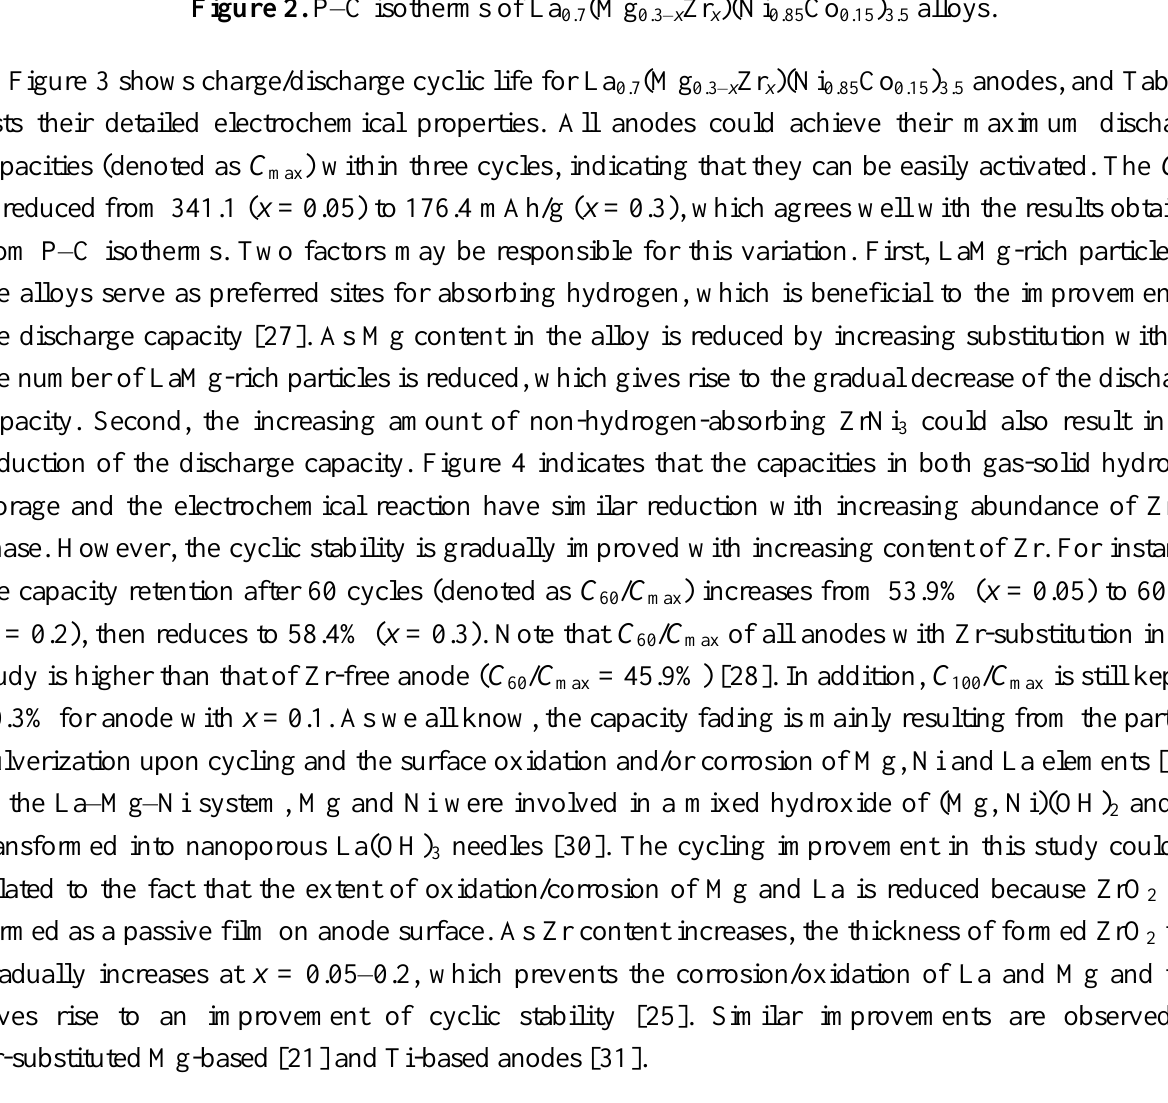
Figure 2. P–C isotherms of La